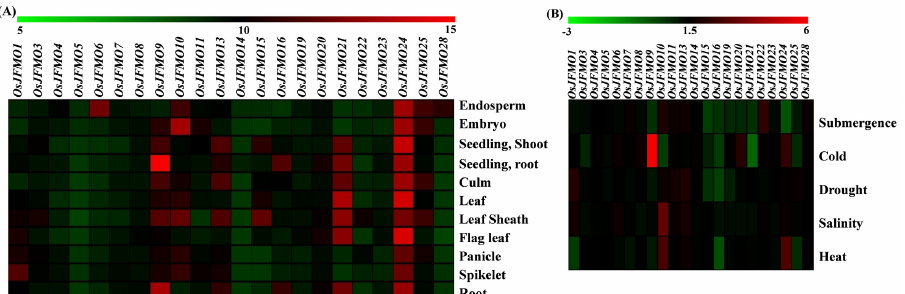
Figure 6. Schematic representation of the domain architecture of the FMO family of proteins in the cultivated and wild relatives of rice. The domain organization of the FMO members in different Oryza species was predicted by the SUPERFAMILY database. FAD; flavin adenine dinucleotide domain, NB; nucleotide-binding domain; retroviral domain. The length of the domains has been represented in proportion to their actual sizes and are not to scale. Domains connected by a red line mean they are split.